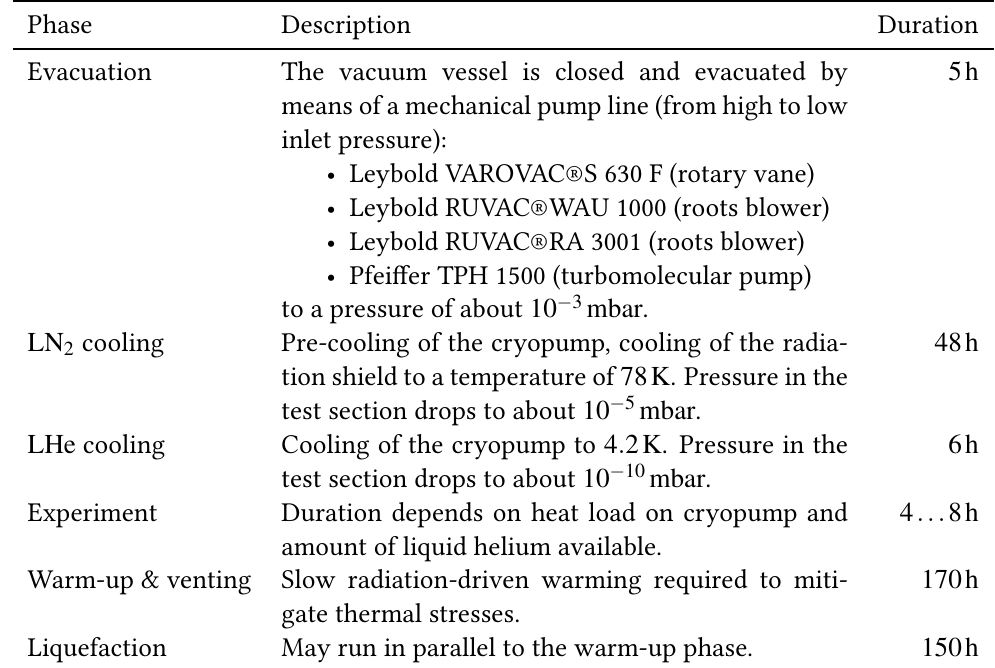
Table 2: Phases of a typical test run in